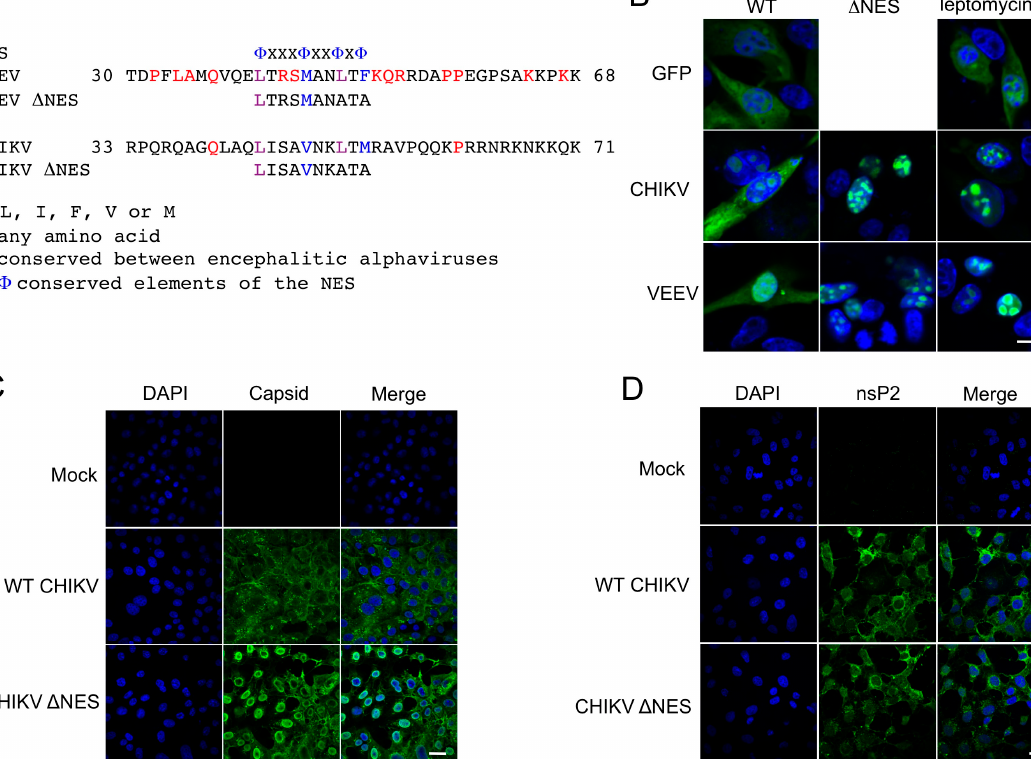
Figure 1. Identification of the CHIKV capsid protein minimal nuclear export sequence. ( A ) Amino acid sequence alignment of CHIKV capsid putative nuclear export sequence against VEEV capsid; ( B ) BHK-21 cells were transfected with pEGFP, pEGFP-CHIKV capsid, pEGFP-VEEV capsid (in the presence or absence of Leptomycin B), pEGFP-CHIKV capsid- ∆ NES, or pEGFP-VEEV capsid- ∆ NES. After 24 h, cells were treated with Leptomycin B for 30 min at 37 °C prior to fixing, and EGFP fluorescence was analyzed by direct visualization. The white bar represents 10 µm; ( C , D ) BHK-21 cells were infected with WT CHIKV or CHIKV Δ NES. After 24 h cells were fixed, permeabilized, and capsid protein ( C ) and nsP2 ( D ) localization were analysed by indirect immunofluorescence using anti-CHIKV capsid and anti-nsP2 antibodies. Images are representative of three independent experiments and at least six fields of view. The white bar represents 25 µm.